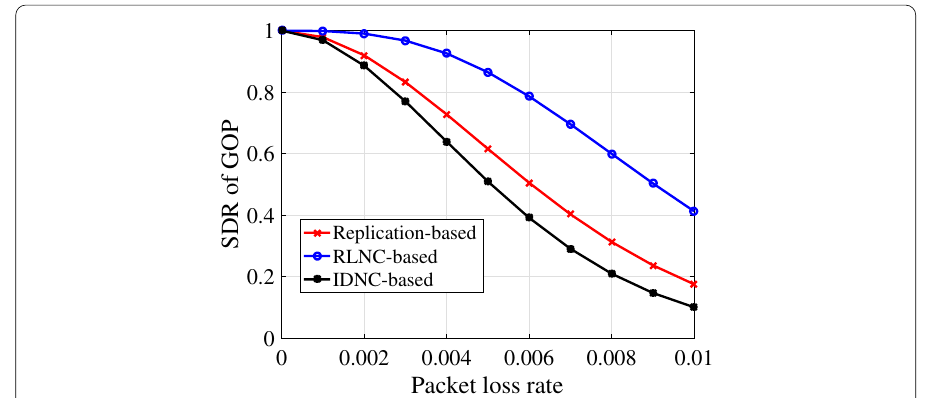
Fig. 8 Comparison of the SDR of GOP in different schemes